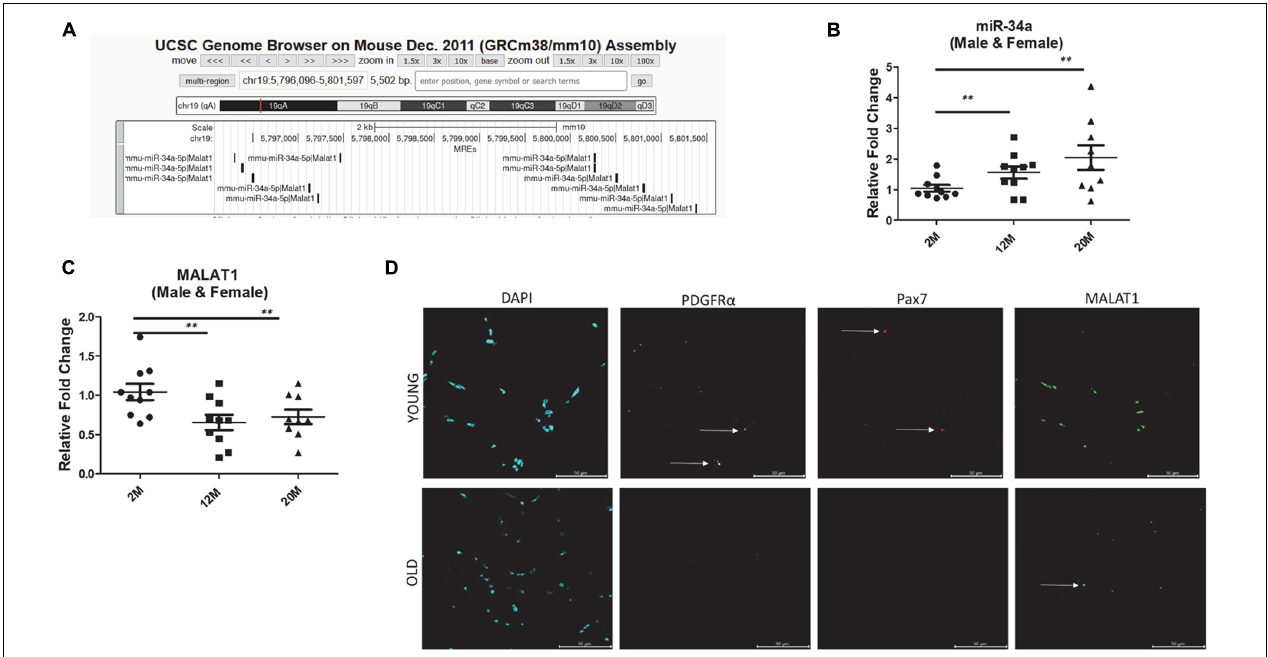
FIGURE 1 | (A) microRNA response elements (MREs) shown for mouse chromosome 19 region of Malat1 illustrating numerous binding sites for miR-34a-5p. (B) Expression of miR-34a-5p in tibialis anterior muscles of male and female mice 2, 12, and 24 months of age showing a significant increase in mir-34a-5p expression with age. (C) Expression of MALAT1 in tibialis anterior muscles of male and female mice 2, 12, and 24 months of age showing a significant decrease in MALAT1 expression with age. (D) Fluorescent images from tibialis anterior cross-sections stained using RNAscope with probes for MALAT1, PDGFR α , and Pax7 showing decreased MALAT1 levels with age. Arrows in (D) indicate positive labeling. ** P <